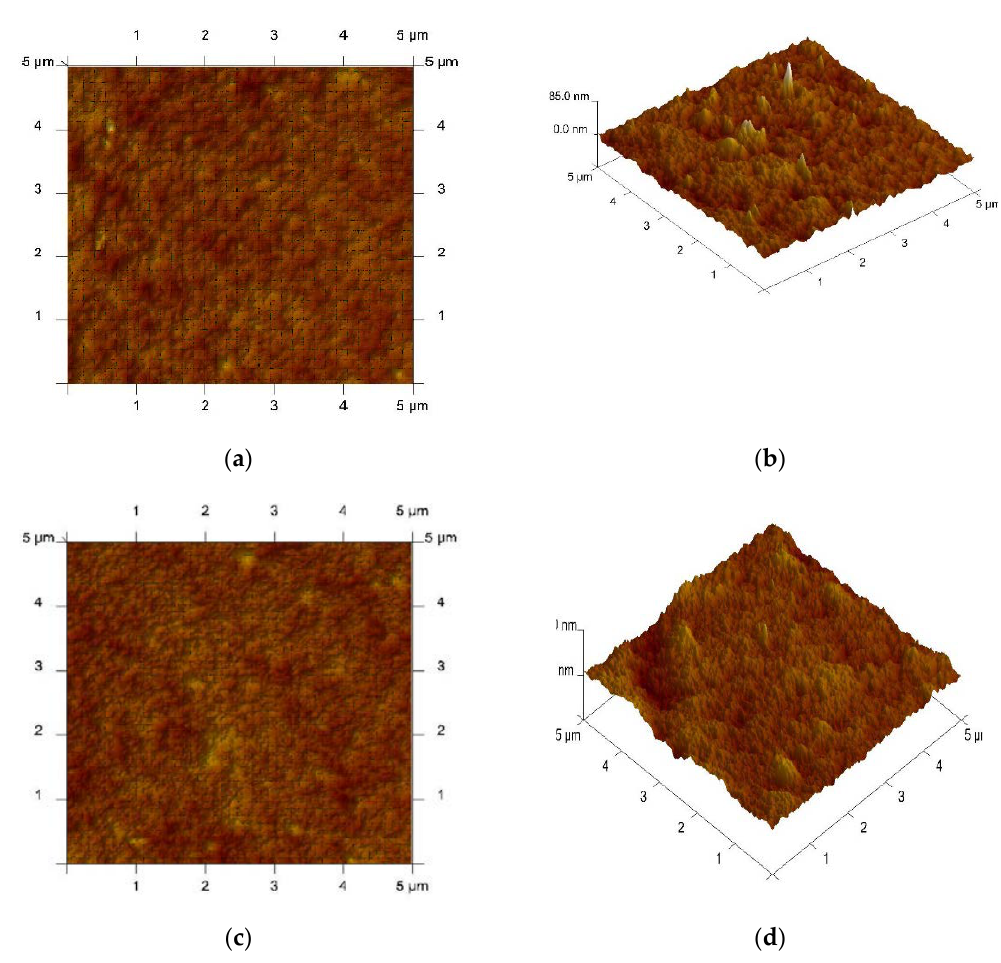
Figure 3. Atomic force microscopy (AFM) images (2D and 3D) of polymer inclusion membranes (PIMs) with alkylimidazol. ( a , b ) 1-hexylimidazole ( 1 ), ( c , d ) 1-hexyl-2-methylimidazole ( 2 ).